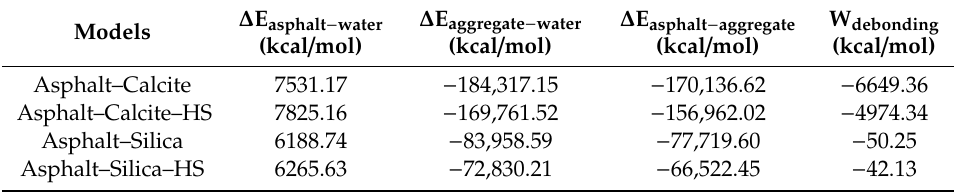
Table 3. Debonding energy and interfacial interaction for different models.